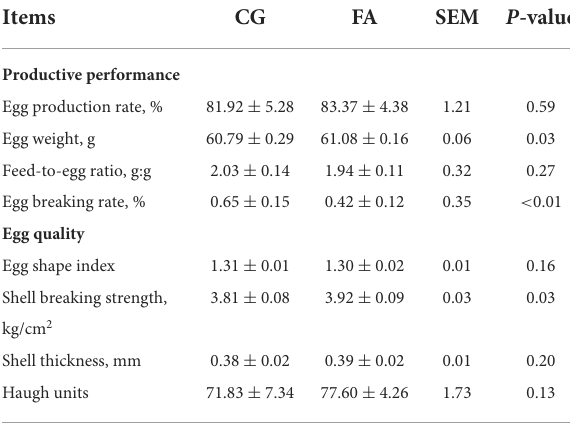
TABLE 2 Egg productive performance and quality.